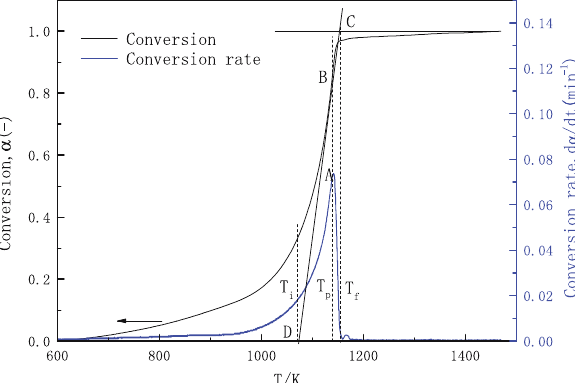
Figure 2: Initial gasi fi cation temperature ( T i ) , the peak conversion temperature ( T p ) and the fi nal gasi fi cition temperature ( T f )